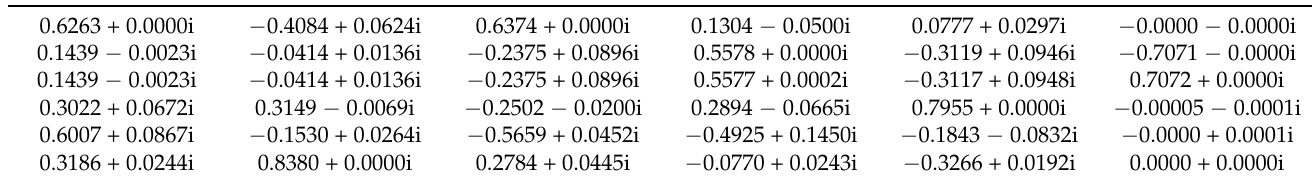
Table 4. Left eigenvector (W = ˆ V